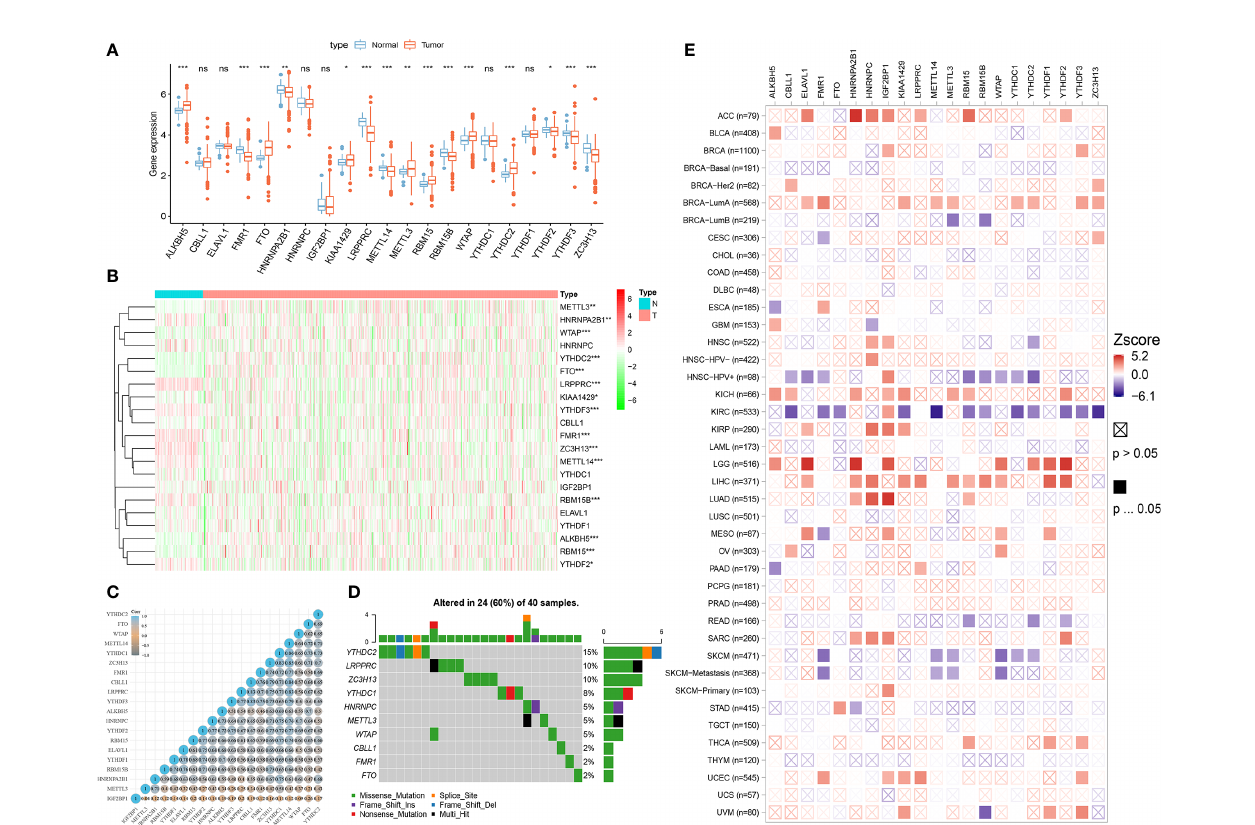
FIGURE 2 | Differential expression, copy number variation landscape and prognostic implications of 21 m6A regulators in cancers. (A) Differential expression level of 21 m 6 A regulators in tumor and normal tissues were assessed using Student ’ s t test. (B) A heat map indicating the m 6 A modi fi cation patterns between tumor tissues and normal tissues. (C) A heat map of the correlation between 21 m 6 A regulators. The horizontal and vertical coordinates represent genes, and different colors represent correlation coef fi cients. (D) Oncoplot displaying the somatic landscape of 21 m6A regulator in ccRCC samples from TCGA database. Mutation information of each gene in each sample was shown in the waterfall plot, where different colors with speci fi c annotations at the bottom meant the various mutation types. (E) Clinical implications of 21 m 6 A regulators expression across various cancer types was estimated in a heatmap using Cox regression methods (ns, not signi fi cant; *p < 0.05, **p < 0.01, ***p <